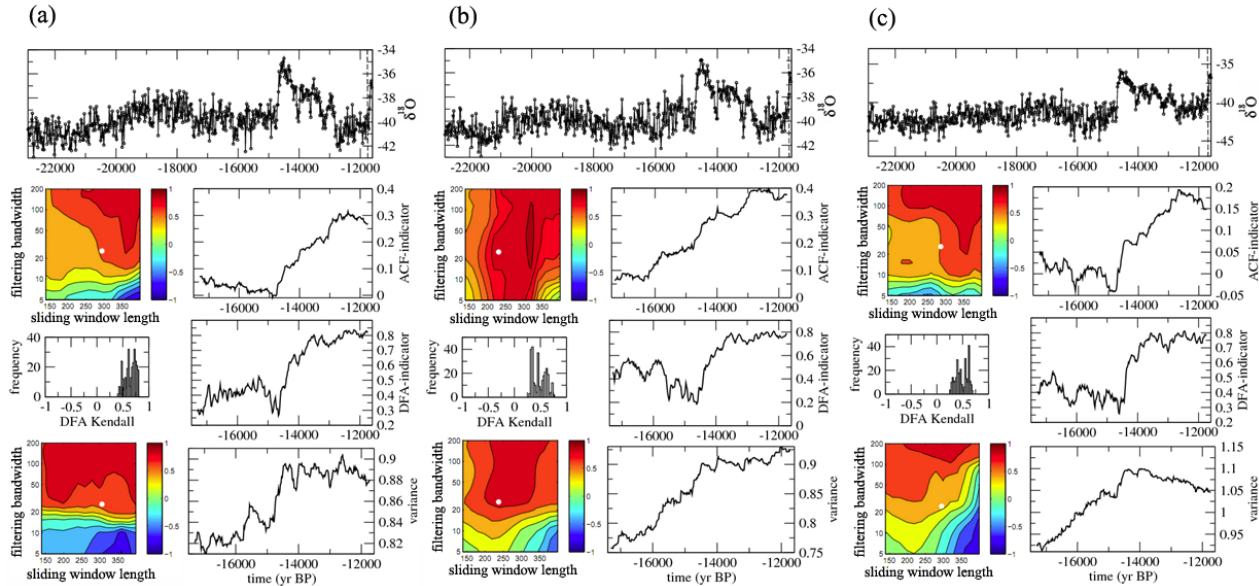
Fig. 3. Indicators of slowing down and changing variance in Greenland ice-core δ 18 O paleo-temperature proxy records through the last deglaciation: (a) GRIP (b) GISP2 (c) NGRIP. In each case, (Top panel) time series of δ 18 O data, where analysis spans 22.88–11.74ka ( n =558), through the Last Glacial Maximum, the Bølling-Allerød, and stopping at the vertical dashed line before the exit from the Younger Dryas. (Left panels) Sensitivity analysis showing values of the Kendall trend statistic for the indicators: (top) ACF, (middle) DFA, (bottom) variance, when varying the sliding window length and (for ACF and variance) the filtering bandwidth used in de-trending. White dots in the contour plots indicate the values of window length and filtering bandwidth used for the example indicators. (Right panels) Example indicators calculated after de-trending, using sliding window length of half the series and (for ACF and variance) a filtering bandwidth of 25: (top) ACF, (middle) DFA, (bottom) variance.